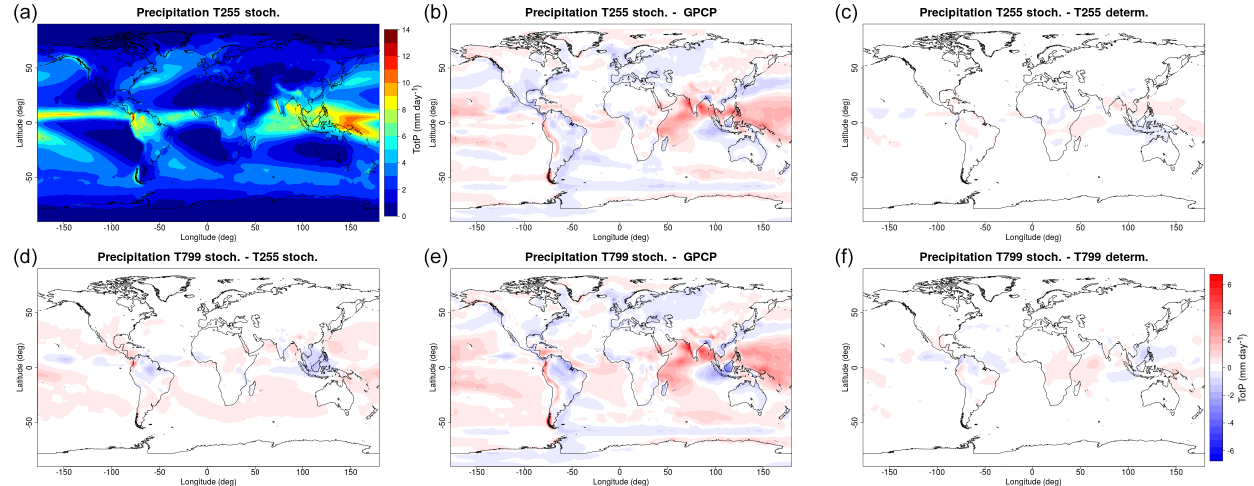
Figure 5. Left: (a) climatological ensemble mean precipitation for the PDA experiments (1979–2008) for T255 with stochastic physics. (d) T799 stochastic minus T255 stochastic precipitation. Centre: T255 (b) and T799 (e) precipitation bias with respect to GPCP. Right: stochastic minus deterministic climatological precipitation for T255 (c) and T799 (f) .